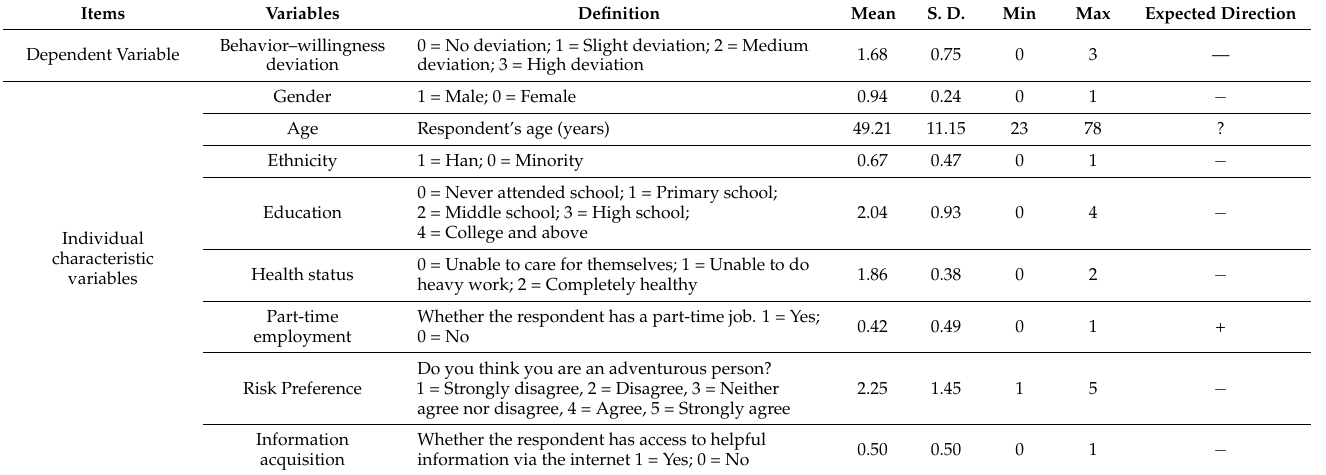
Table 3. Variables of the model and descriptive